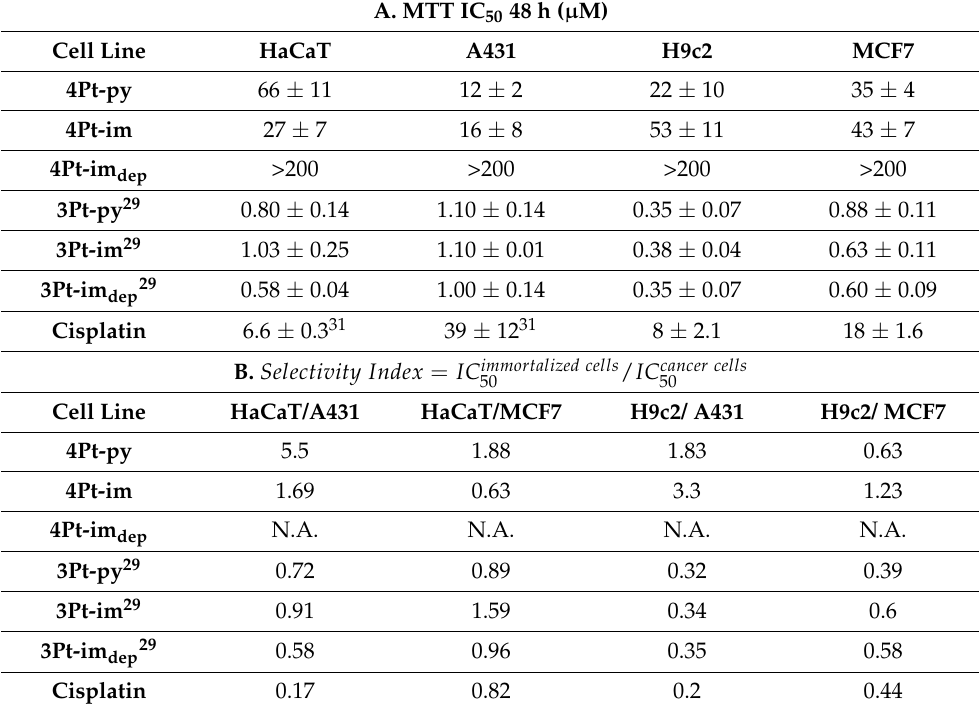
Table 1. ( A ) IC 50 values ( µ M) obtained for Pt-derived drugs on immortalized and cancer cells after 48 h incubation. ( B ) Selectivity index, indicated by the ratio between the IC 50 values of immortalized cells and cancer